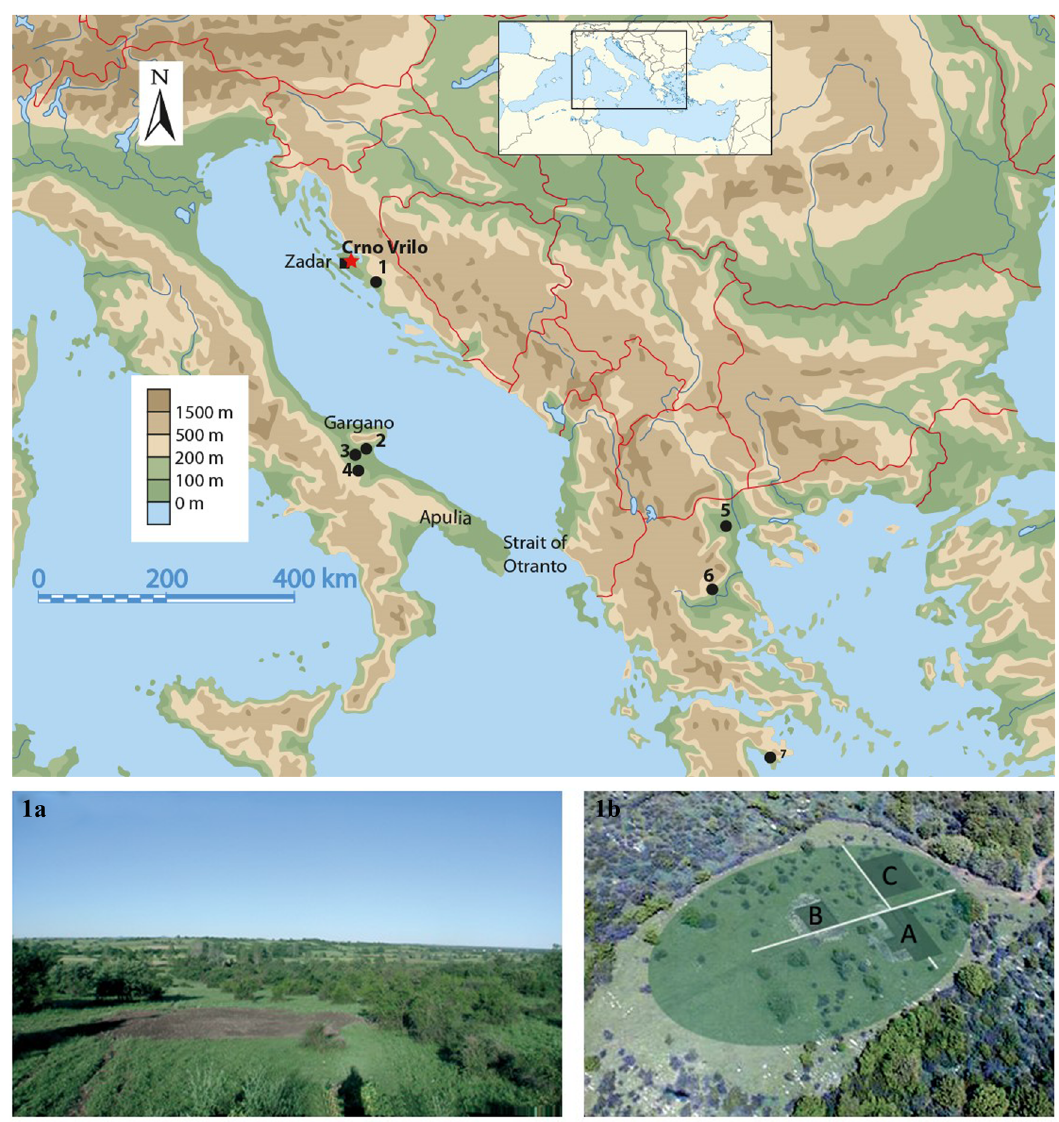
Figure 1: Location of the Crno Vrilo site and the sites mentioned in text: ( 1 ) Pokrovnik, ( 2 ) Passo di Corvo, ( 3 ) Ripa Tetta, ( 4 ) Rendina, ( 5 ) Nea Nikomedeia, ( 6 ) Argissa, and ( 7 ) Franchthi ( base map E. Tessier ) . 1a Position of the site. 1b. Presumed settlement size ( oval shaped ) and excavated areas ( sectors A, B, and C ) , modi fi ed after Marijanovi ć ( 2009, p. 20 ) .